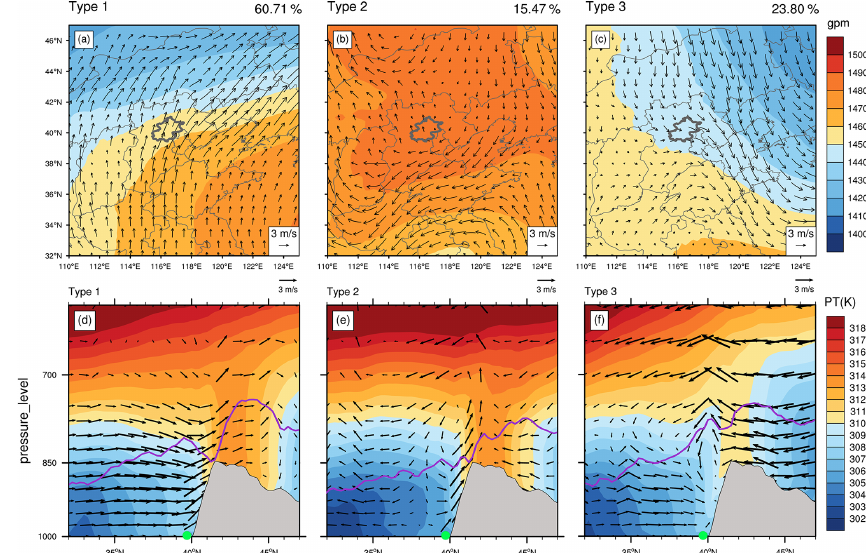
Figure 7. (a–c) 850hPa GH (contours) and υν wind (vectors) patterns related to HW and O 3 pollution compound events based on objective classification (grey outline represents Beijing, and the number in the upper-right corner of each panel indicates the frequency of occurrence of each pattern). (d–f) Vertical cross-sections of the potential temperature (contours) and wind vectors (synthesized by ν and scaled ω , ω scaled by 100) averaged between 116.0 and 117.0 ◦ E, associated with the synoptic patterns (solid purple lines mark the BLH, grey contours mark the topography, and the green dot marks the location of